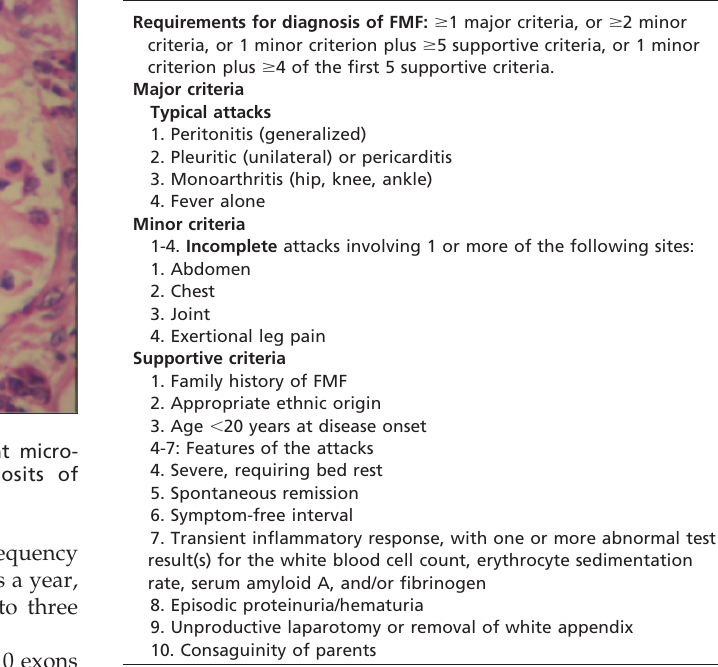
Table 1 - Criteria for the diagnosis of FMF